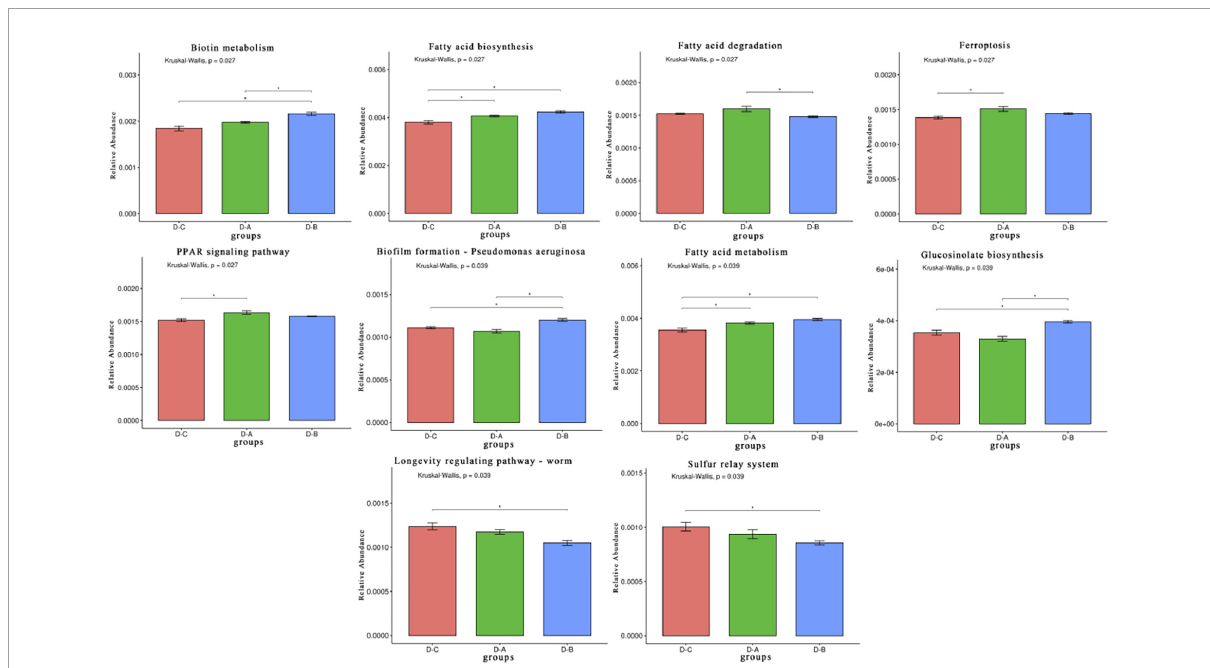
FIGURE5 Rumen microbiota functional profiles. Differential Kyoto Encyclopedia of Genes and Genomes (KEGG) pathways were selected. * P < 0.05.